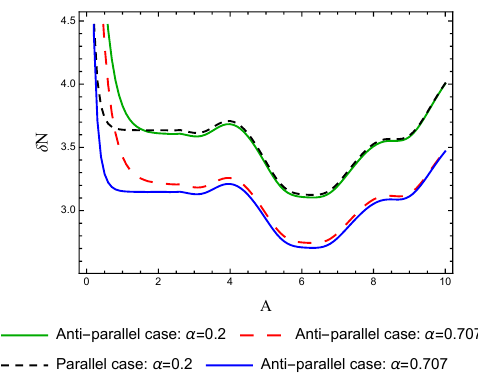
Figure 12 . Anti-parallelly accelerating and parallelly accelerating detectors in (1 + 3) dimensions: plot for different fixed values of the coefficient α with ∆ E B δ N VS A = ∆ E A a A